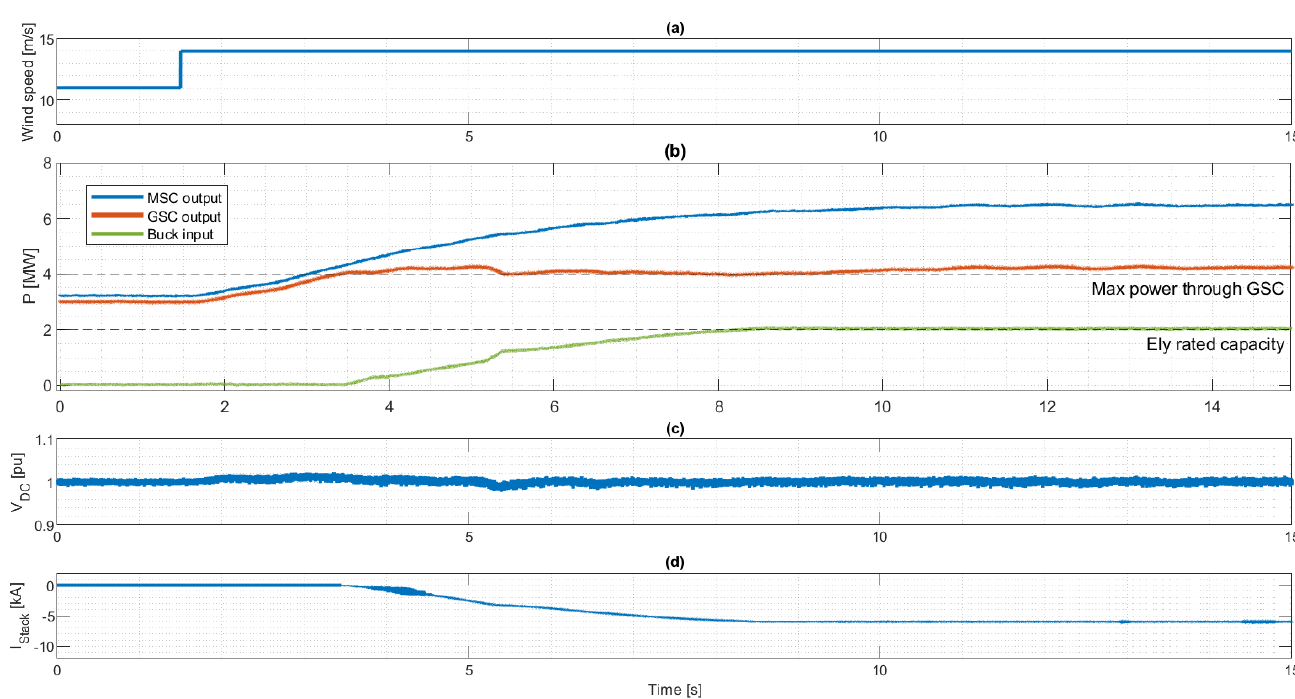
Figure 14. Time response of DC link 1 under wind speed step from 11 to 14 m/s. ( a ) Wind speed pattern. ( b ) Active power measurements. ( c ) DC voltage. ( d ) DC